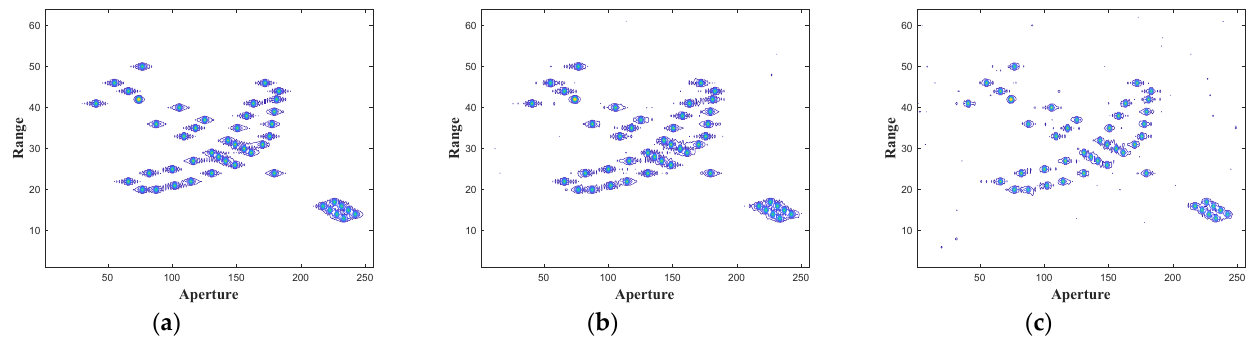
Figure 7. The range profile of the data with different SNR levels. ( a ) 20 dB. ( b ) 10 dB. ( c ) 5 dB.